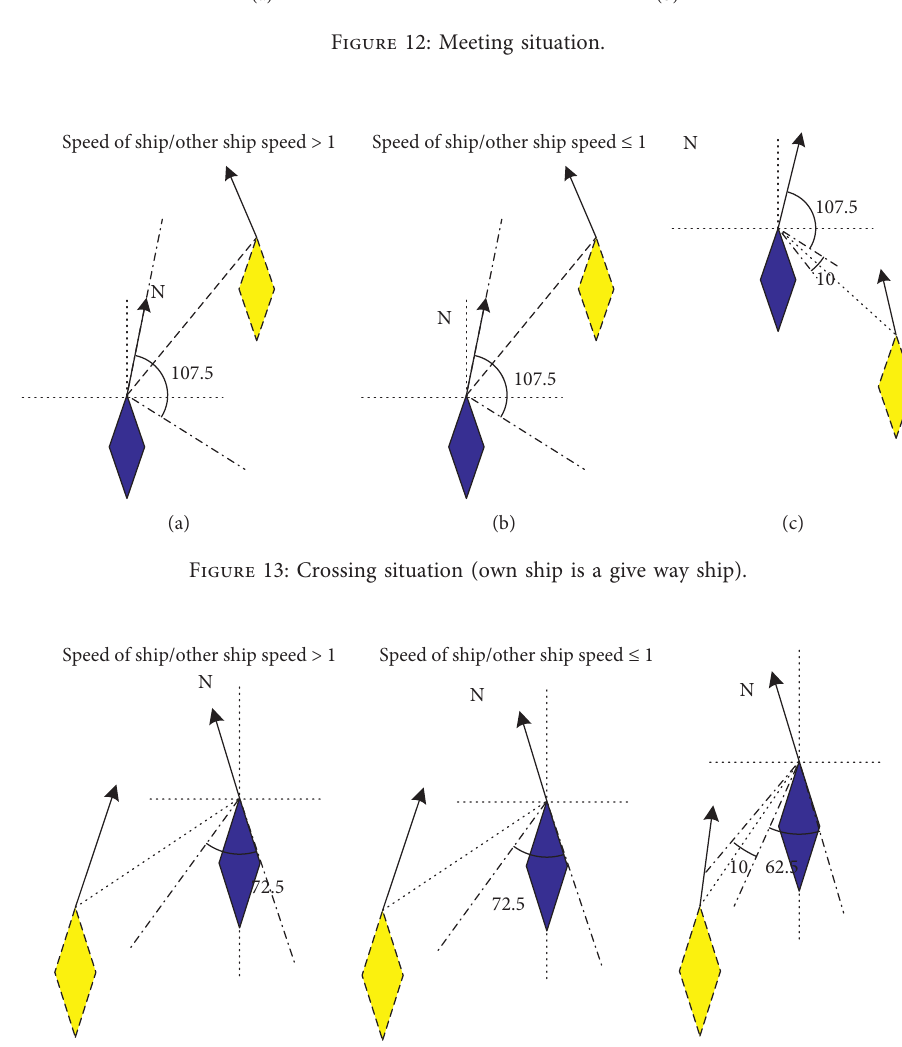
Figure 12: Meeting